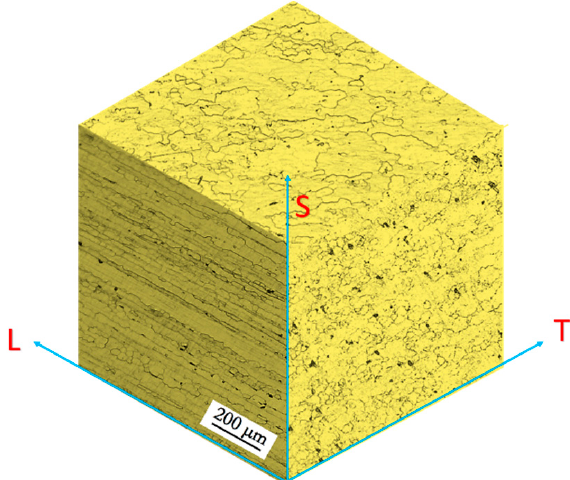
Figure 2. Optical microscope image of A7N01P-T4 aluminum alloy. Orientation: rolled (L), long transverse (T), and thickness (S).